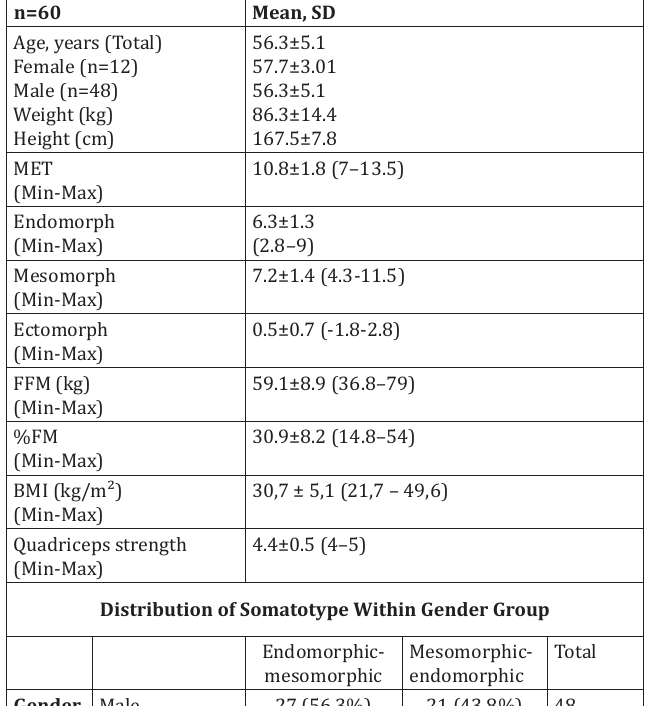
Descriptive Data of Exercise Capacity, Somatotype Components, BMI, Body Fat, and Quadriceps